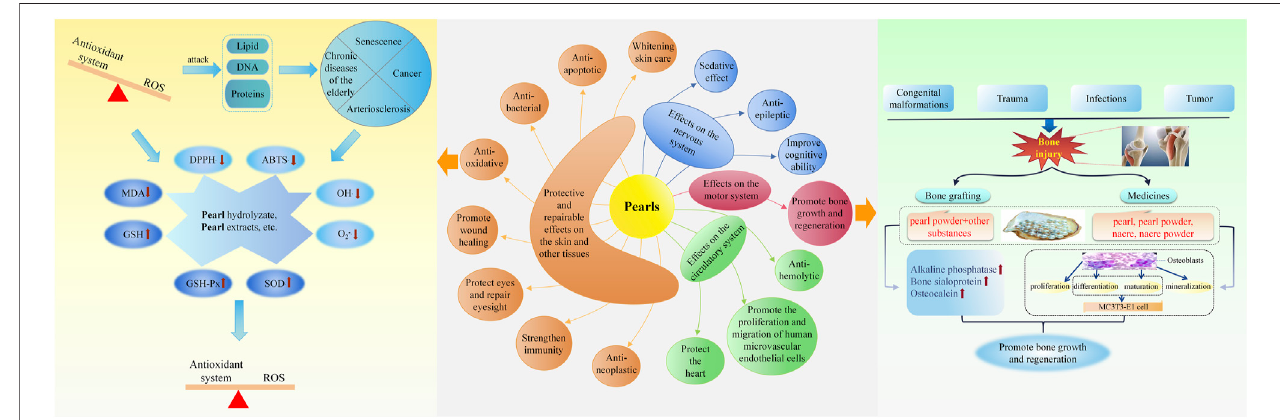
FIGURE 2 | Schematic diagram of the pharmacological effects of pearls and part of the mechanism of action.